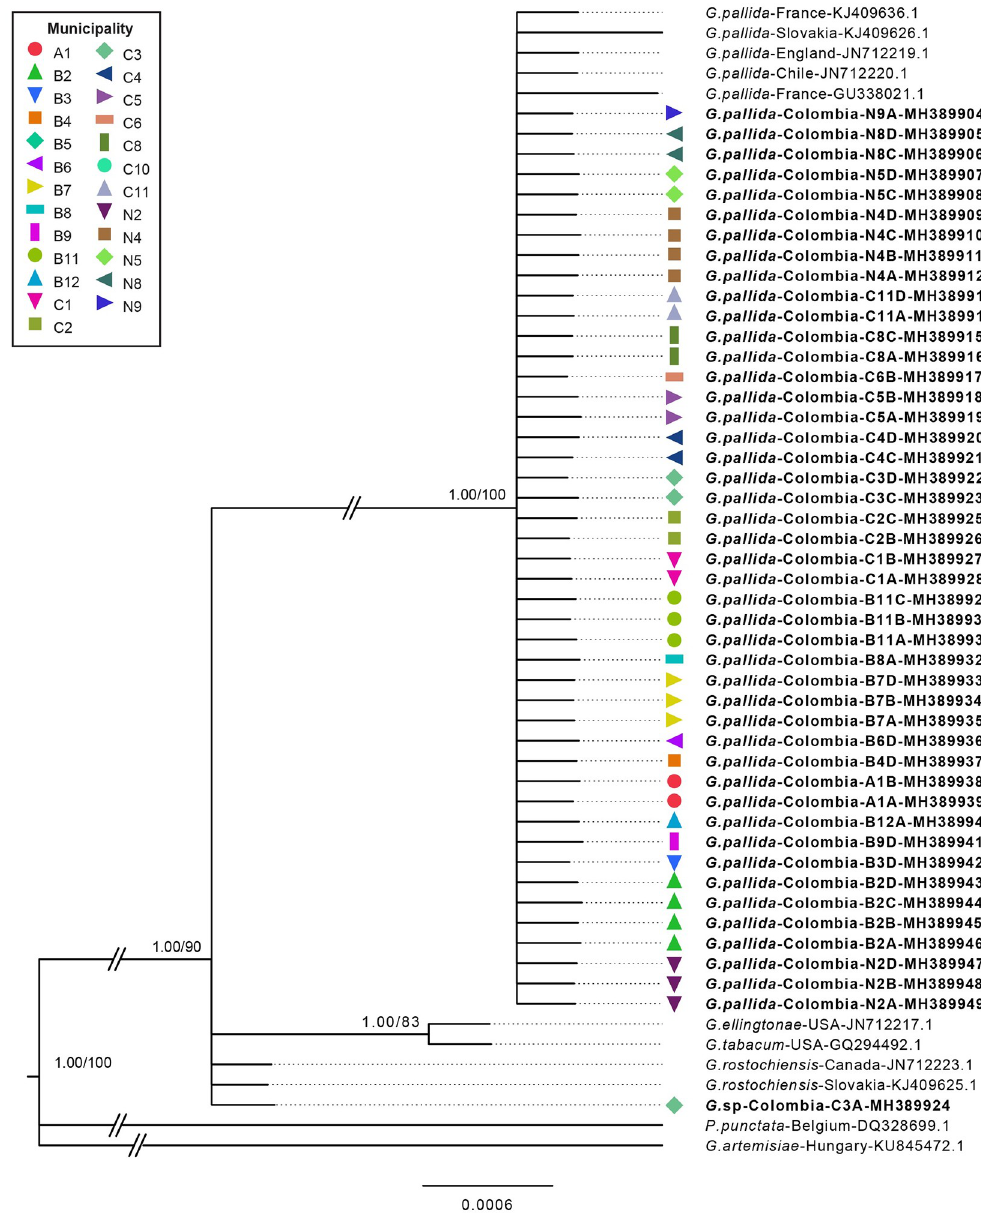
Fig 3. Phylogenetic relationships within the genus Globodera . Bayesian 50% majority rule consensus trees as inferred from D2–D3 expansion segments of 28S rRNA as a single partition with HKY model. Node-support values: Left value posterior probability BI shown if > 95%, right value bootstrap from ML analysis shown only if > 70%. Newly obtained sequences in this study are in